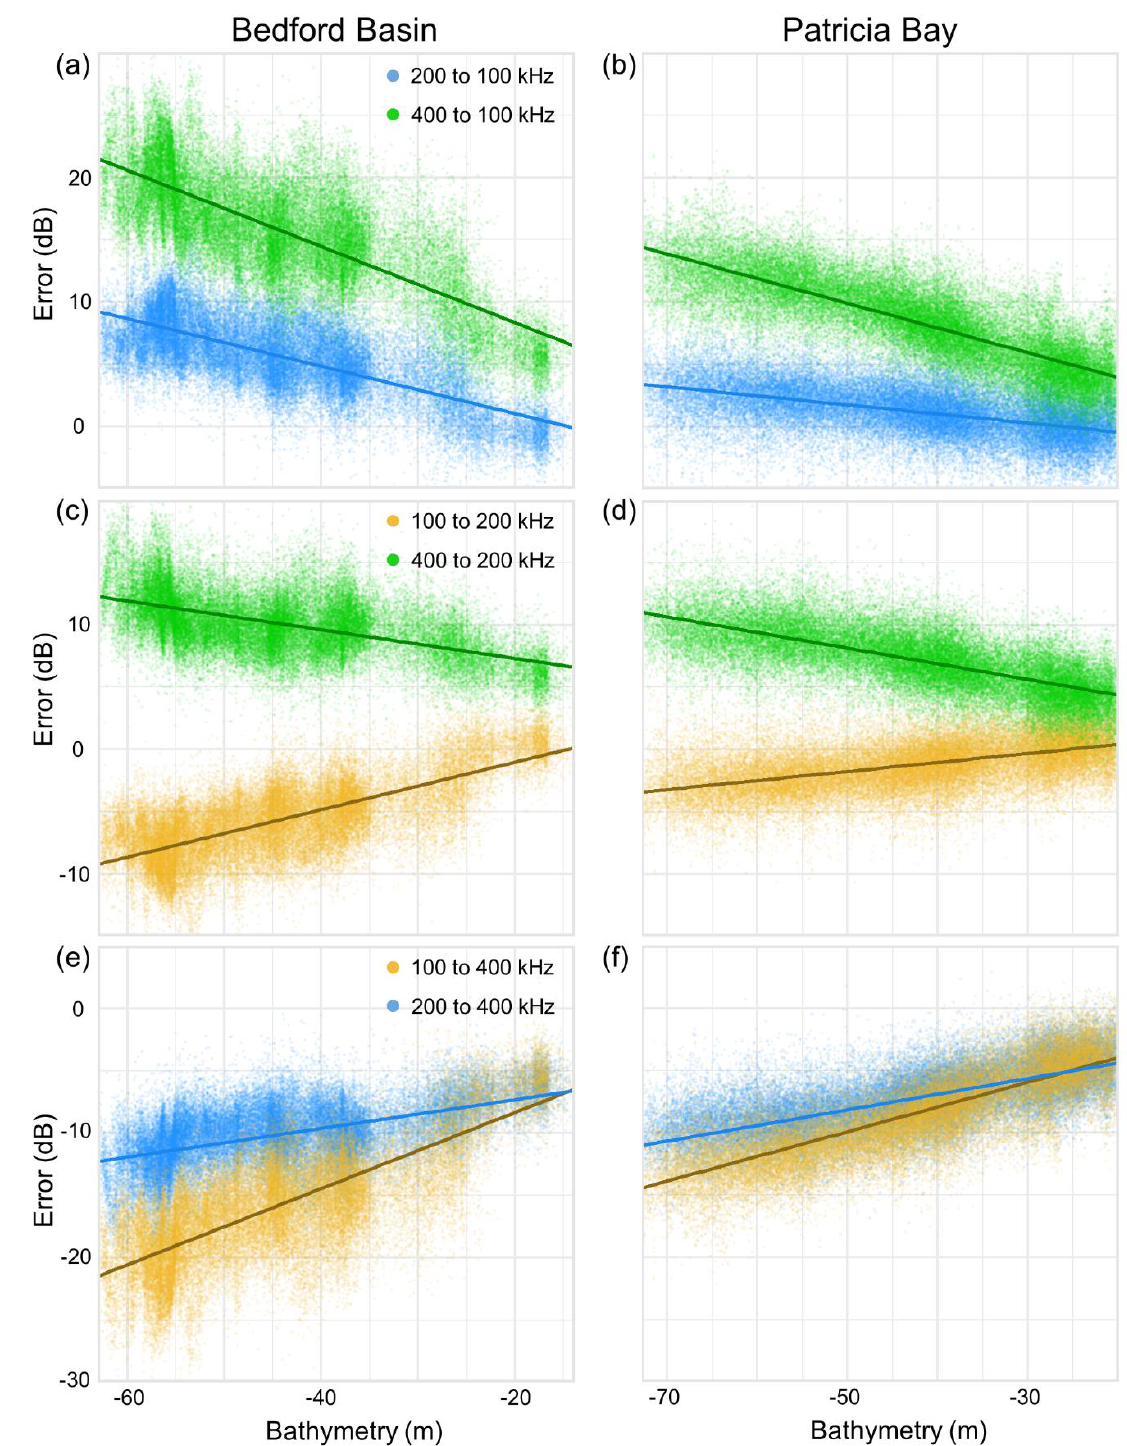
Figure 13. Linear relationships between bathymetry and backscatter error for multiple frequencies at ( a ), ( c ), ( e ) Bedford Basin, and ( b ), ( d ), and ( f ) Patricia Bay.